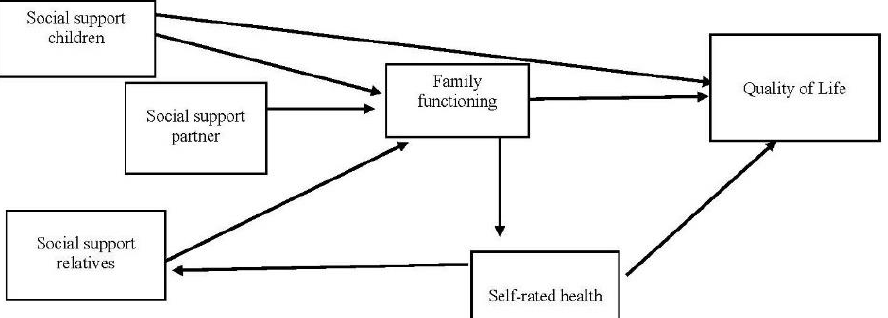
Figure 1. Hypothesized model.